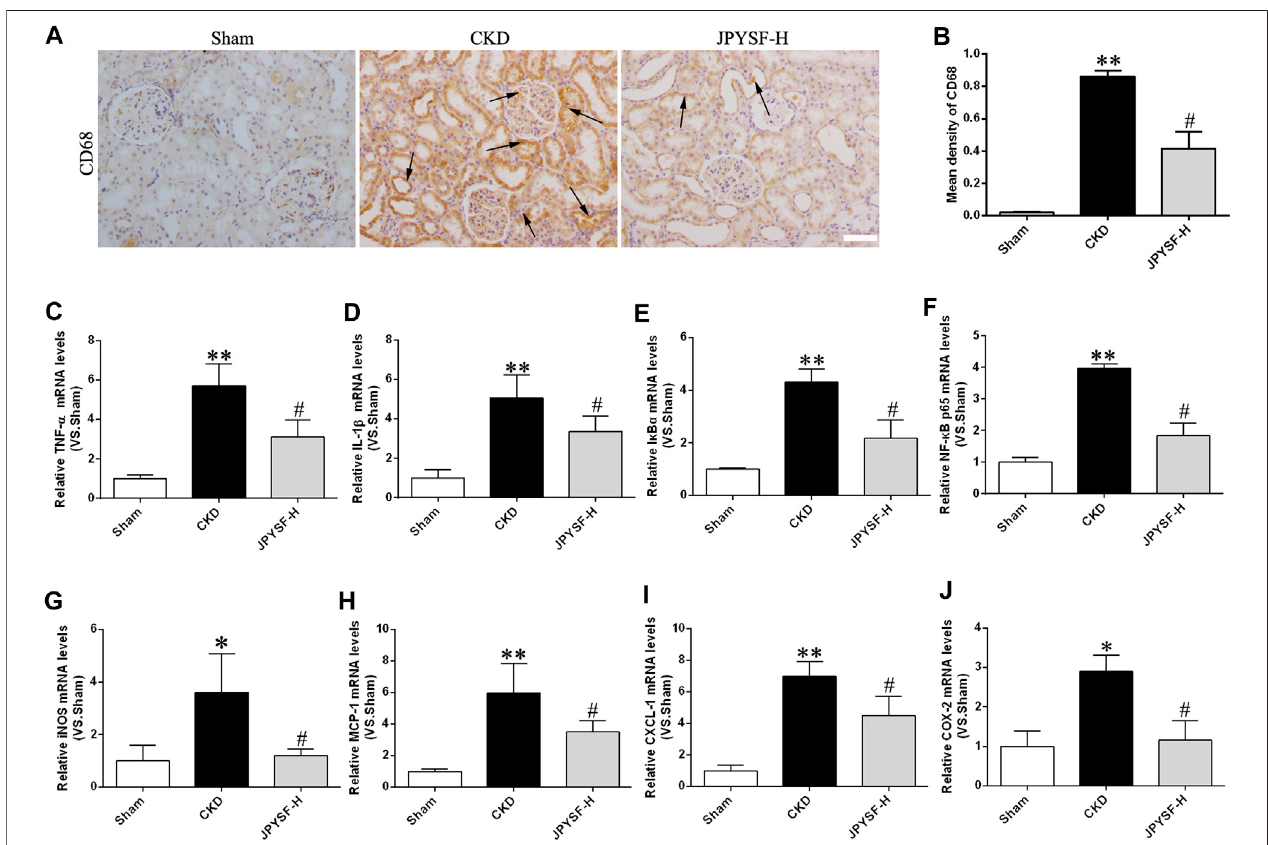
FIGURE 3 | JPYS formula suppresses in fl ammation in CKD rats. (A) IHC staining of CD68 in the kidney ( × 200, scale bar (cid:2) 100 μ m). CD68-positive areas are indicatedbyarrows. (B) Quanti fi cationofCD68density.RelativemRNAexpressionlevelsofTNF- α (C) ,IL-1 β (D) ,I κ B α (E) ,NF- κ Bp65 (F) ,iNOS (G) ,MCP-1 (H) ,CXCL-1, (I) and COX-2 (J) . All data are expressed as means ± SEM. * p < 0.05, ** p < 0.01 vs. the sham group; # p < 0.05 vs. CKD